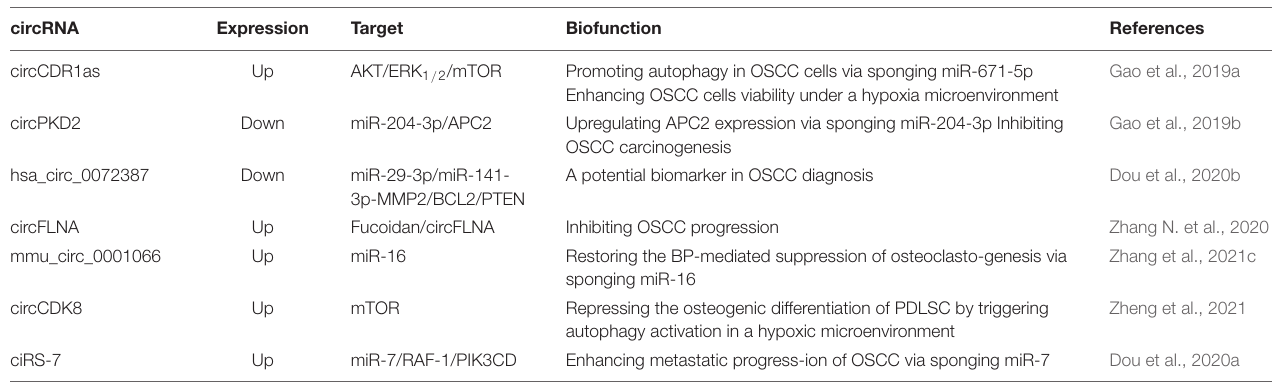
FIGURE 2 | Biofunction of miRNAs in ferroptosis mechanism. Current reports focus on several essential enzymes (e.g., Nrf2, GLS, and GPXs) that impact ferroptosis progression. Among those, Nrf2 holds an irreplaceable role in the regulatory network because of its double value in both ferroptosis and apoptosis. TABLE 2 | Our previous studies related to circRNAs in osteogenesis and